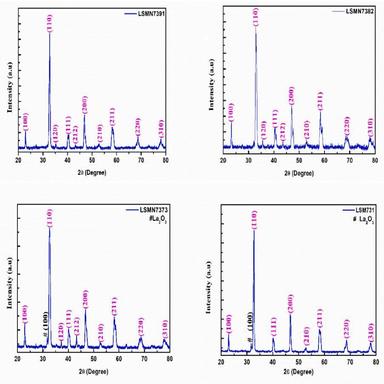
XRD spectra of comparisons LSMN7391, LSMN7382, LSMN7373 and LSM731.